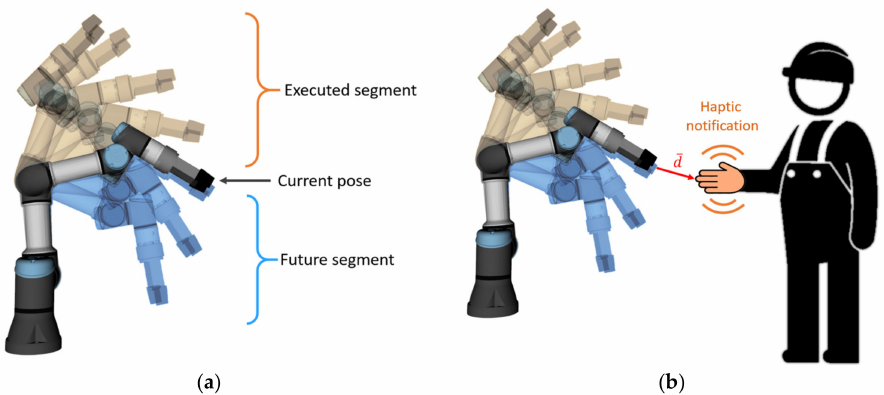
Figure 1. ( a ) Trajectory execution: already executed segment of trajectory, current state, and future segment (planned trajectory segment yet to be executed); ( b ) human worker equipped with haptic feedback device, which provides vibration alert about the proximity to the future trajectory of the → d . Note: collision vector is calculated considering all points of robot; collision vector is denoted as the robot body, including all links and